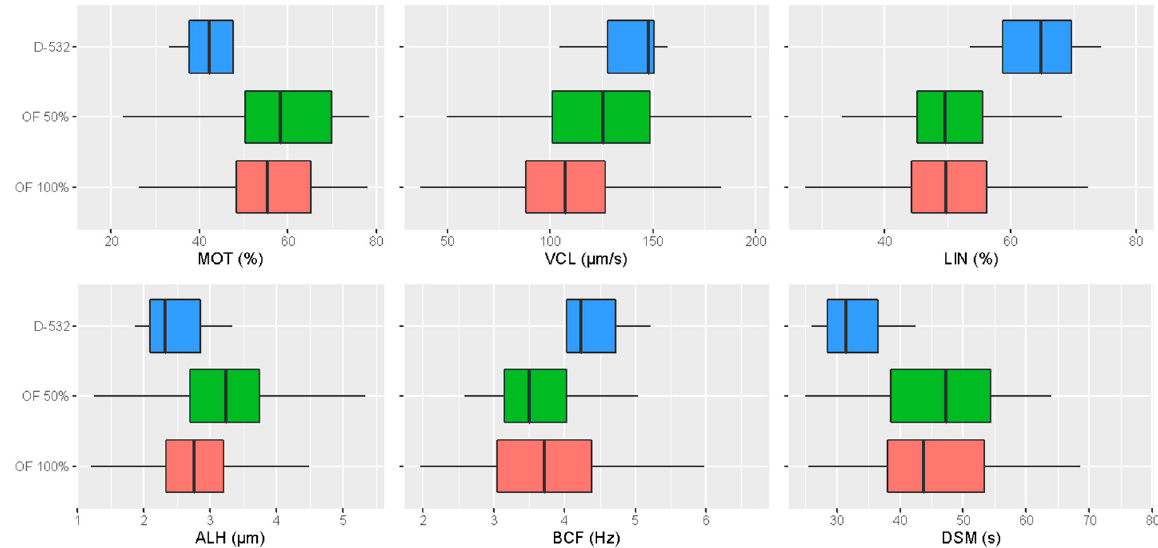
Figure 1. Boxplots displaying the “within” and “between” treatments variability concerning the main sperm motility parameters (outliers are not shown). Table 2. Selection of the best-fitting model for Mixed Model ANOVAs isolating the OF groups, with the treatment (OF 100% vs. OF 50%) as a fixed factor and male, female or their interaction as random factors. Only the parameters with significative differences among treatments are